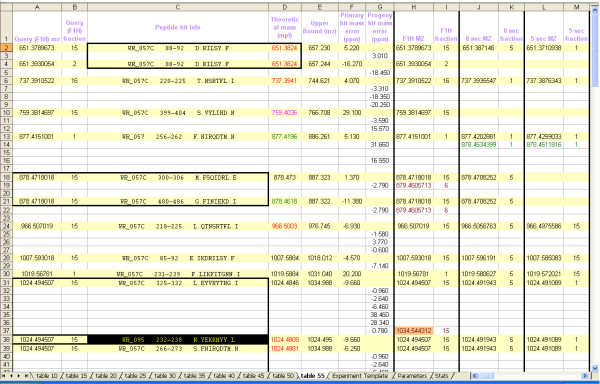
Screenshot showing upper left segment of TOF2H-Processor output. Columns B – E, comprising query peptide info (m/z, fraction, accession/endpoints/sequence), theoretical mass and "upper bound" contain data imported from the refMPL. Column D coloration indicates refMPL sheet of origin. Any adduct hits (not shown) are recorded with blue text coloration of the peptide info cell with adduct info stated. Columns F – G show mass errors. Remaining columns show mass-matching HDX timepoints data. Yellow bars denote primary hits, green masses in deuterium-uptake timepoints show "isotope progeny" of the primary hit masses (progeny were more plentiful in the longer timepoints further to the right, not shown). For isotope progeny searching, the search algorithm can progressively relax mass tolerances with increasing theoretical isotope increments. Brown masses are "false progeny". True progeny listed beneath a false progeny in timepoint samples, are typically isotope progeny (deuteration) of the false progeny. Salmon background denotes the progeny mass that was initially hit from among those on the same row. Inverted coloration (yellow text against black background) indicates a decoy hit. Black borders surround ambiguous hits (either more than one query hitting same theoretical mass (eg. upper box), or a single query hitting more than one theoretical mass (eg. center box). Good forward exchange/relatively low BE is indicated by increased spacing between yellow bars (more numerous progeny, out of view). Inferior results (not shown) would be immediately apparent as fewer progeny (little or no spacing between yellow bars).